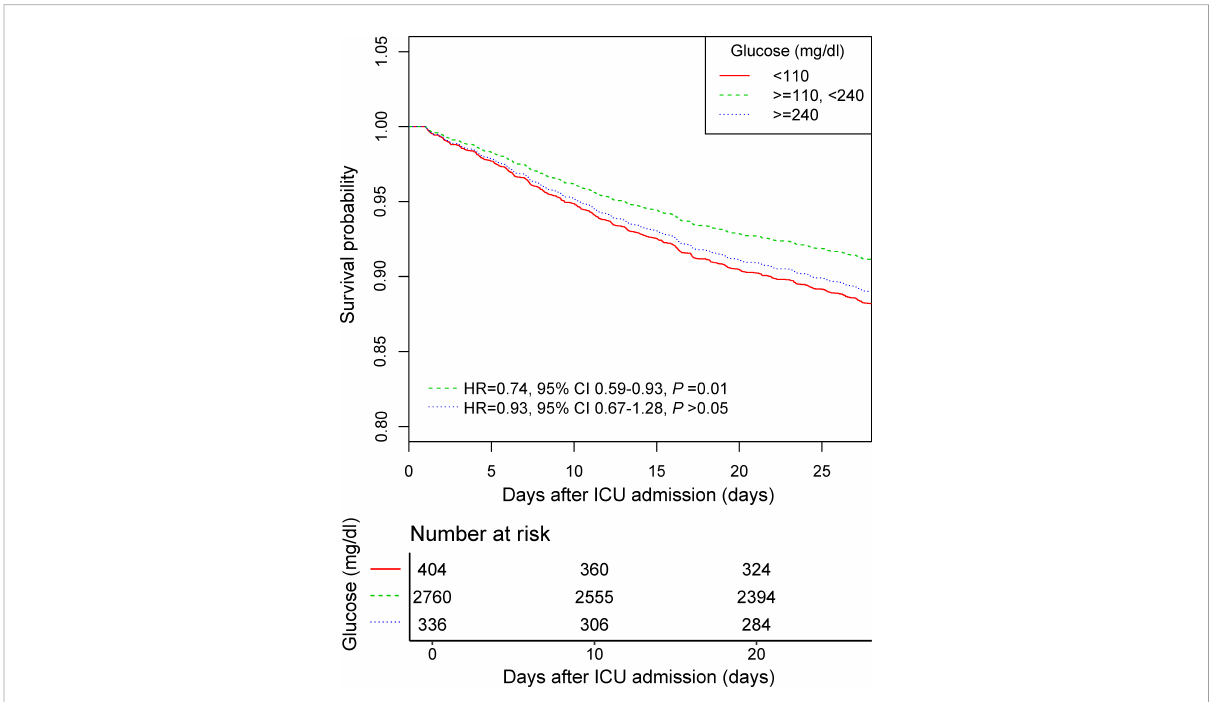
FIGURE 3 The 28-day survival curve of the Cox regression model for participants with in fl ection point grouping of glucose. Adjusted by age, sex, SOFA, infection site, mechanical ventilation on fi rst day, renal replacement therapy on fi rst day, congestive heart failure, cardiac arrhythmias, valvular disease, peripheral vascular disease, hypertension, other neurological diseases, chronic pulmonary disease, liver disease, renal failure, AIDS, lymphoma, metastatic cancer, solid tumor, obesity, fl uid and electrolyte disorders, alcohol abuse, drug abuse, and depression. SOFA, sequential organ failure assessment; AIDS, acquired immune de fi ciency syndrome.